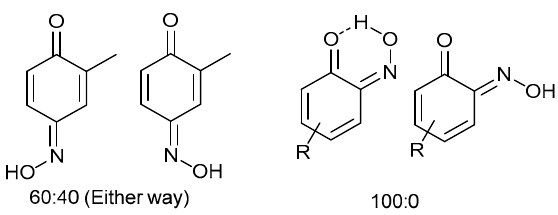
Figure 3. The E / Z isomerism in benzoquinones, with approximate product ratios. Figure 3. The E/Z isomerism in benzoquinones, with approximate product ratios. Figure 3. The E/Z isomerism in benzoquinones, with approximate product ratios.